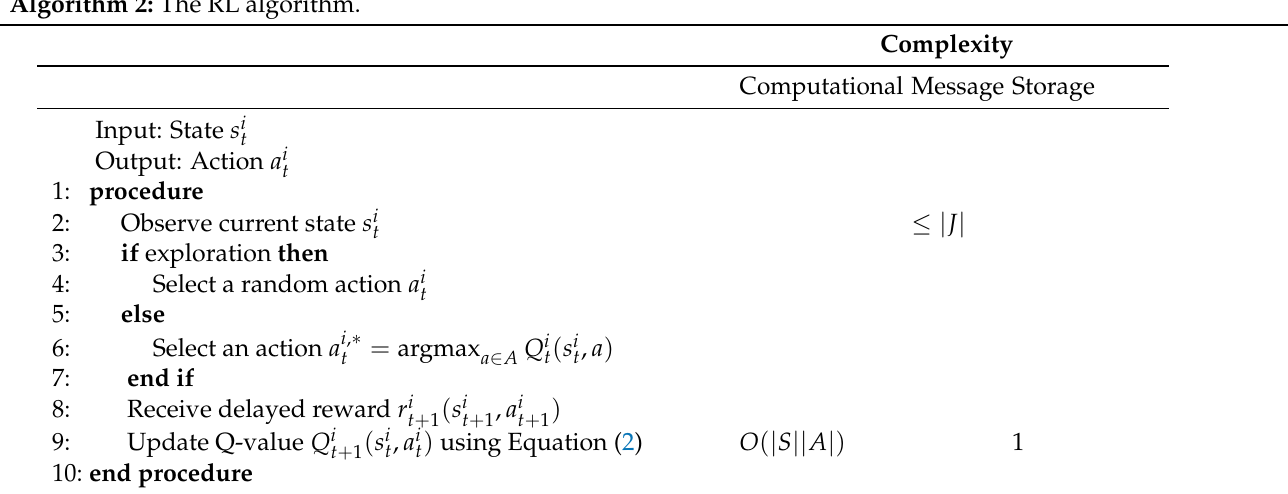
Algorithm 2: The RL